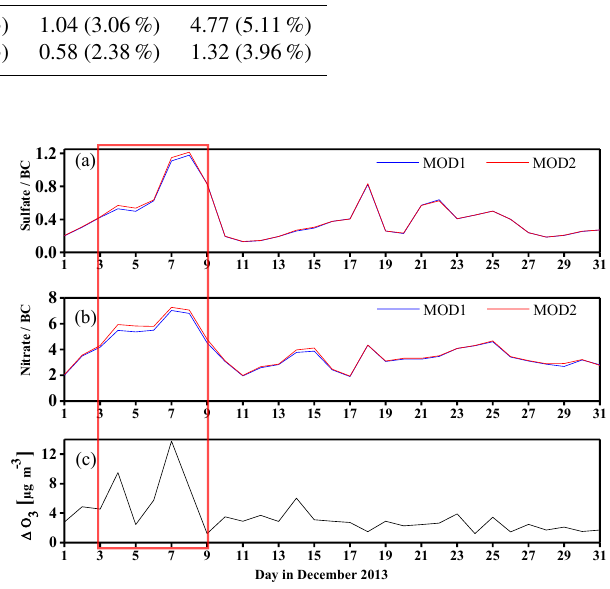
Figure 7. Daily variations in (a) sulfate / BC, (b) nitrate / BC, and (c) difference in O 3 (MOD2–MOD1) averaged over Jiangsu with the red rectangular column marking the severe haze episode (3– 8 December); the increase of sulfate / BC and nitrate/BC suggests enhanced chemical productions.